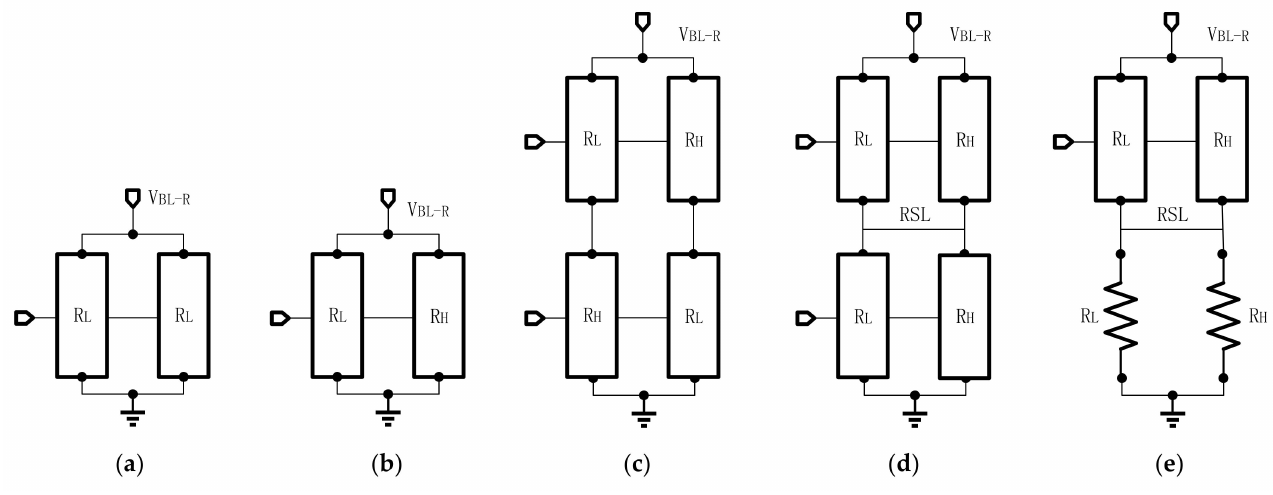
Figure 3. Different connection modes: ( a ) parallel; ( b ) R H + R L Avg; ( c ) series-parallel; ( d ) parallel-series; ( e ) hybrid